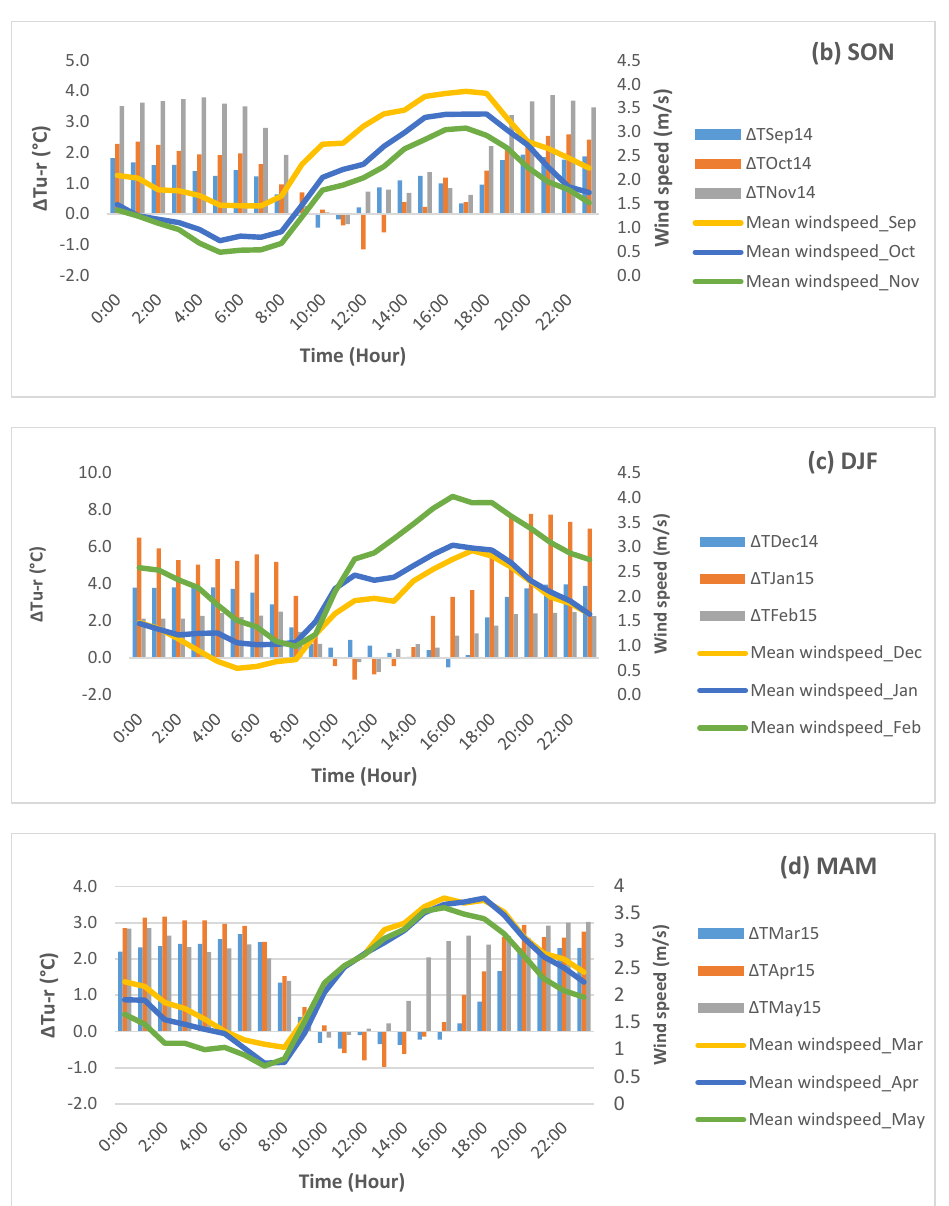
Figure 9. The effect of wind speed on UHI pattern in ( a ) JJA; ( b ) SON; ( c ) DJF and ( d ) MAM.